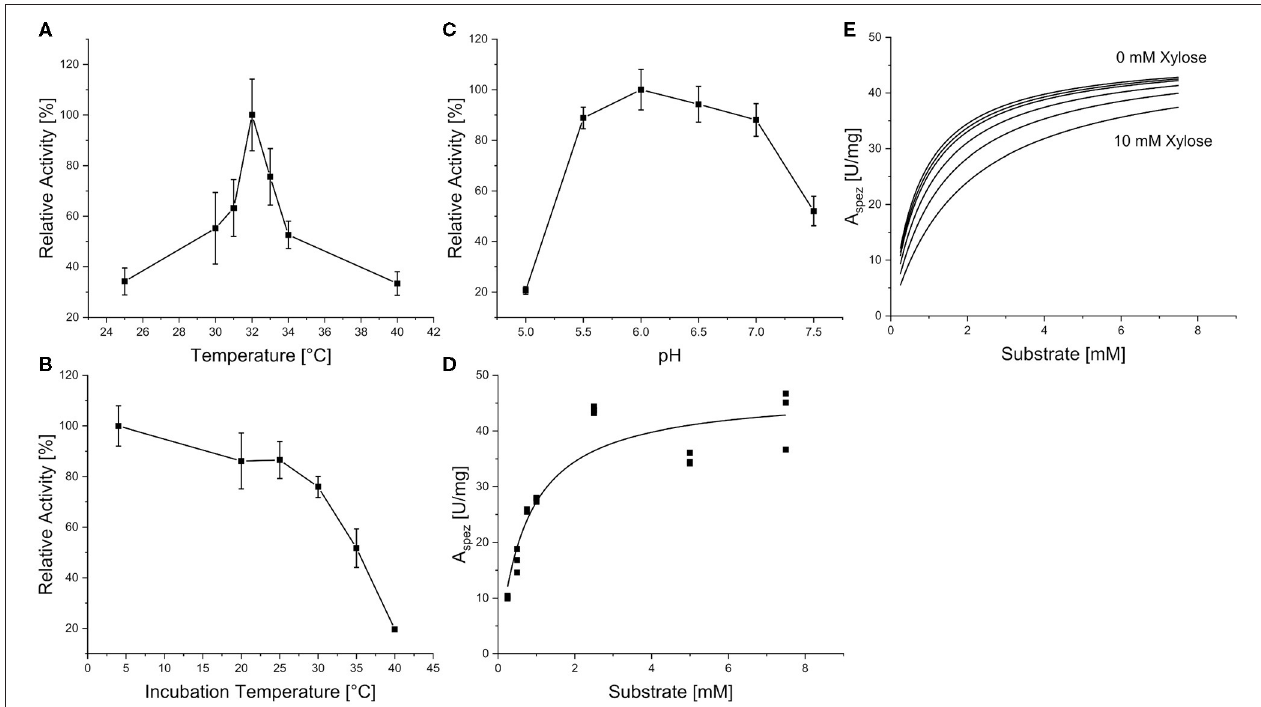
FIGURE 3 | Biochemical characteristics of Xyl43Nc with 4-Nitrophenol-xylopyranoside as substrate. Activities are given in relation to the strongest activity at different reaction temperatures (A) , after incubation of the enzyme for 1h at different temperatures (B) and at different pH values (C) . Reaction kinetics without product inhibition with measured specific activities and corresponding fitted curve (D) . Fitted reaction kinetics with different xylose concentrations between 0 and 10mM (E)